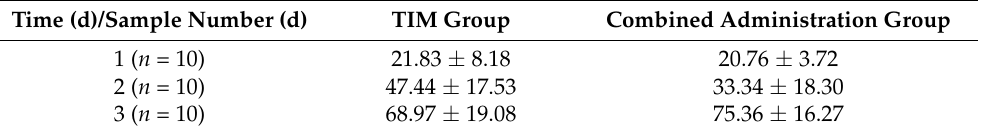
Figure 3. Time-lapse graphs of CIP in eggs. Note: CIP (ciprofloxacin), EF (enrofloxacin), TIM (tilmicosin). The data were expressed as mean ± SD. * p < 0.05 denoted statistical significance.